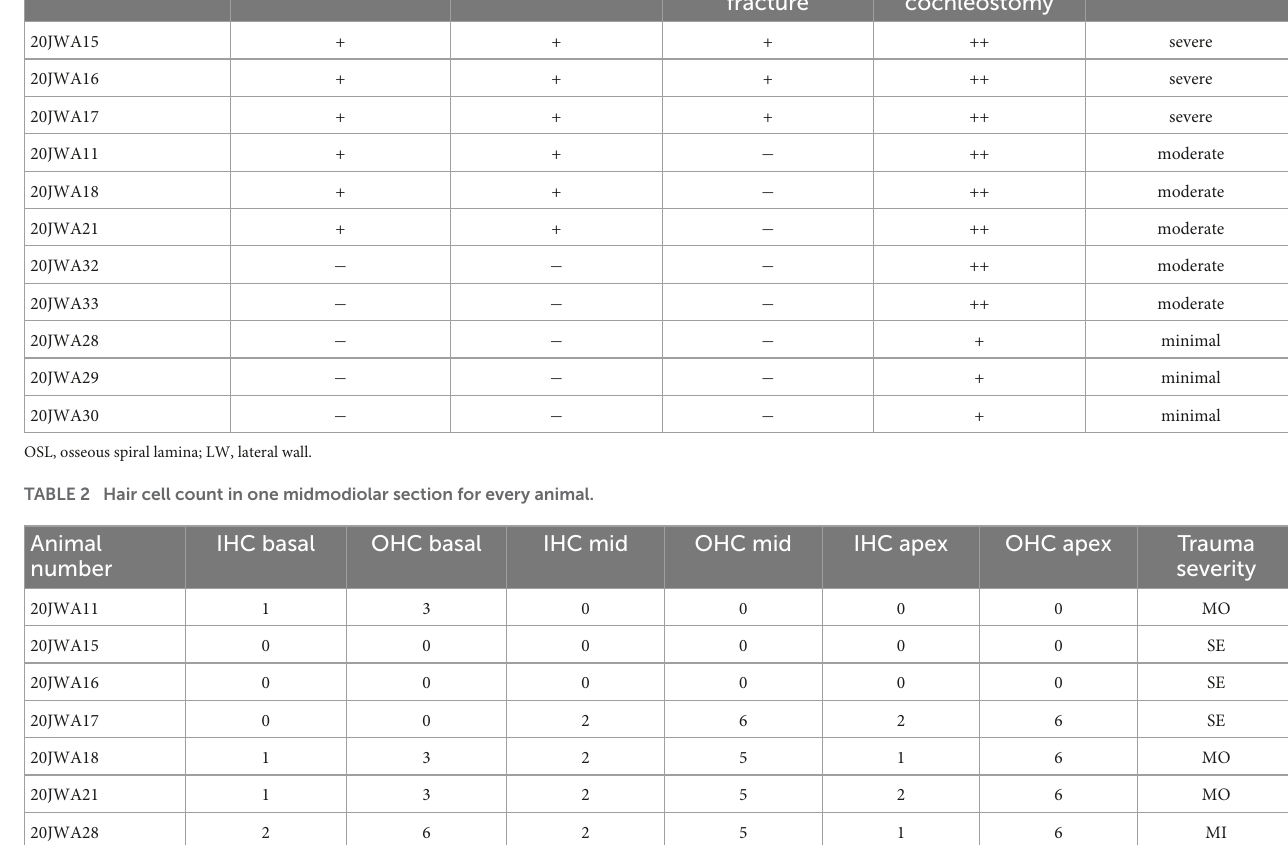
LW damage at Trauma rating fracture cochleostomy